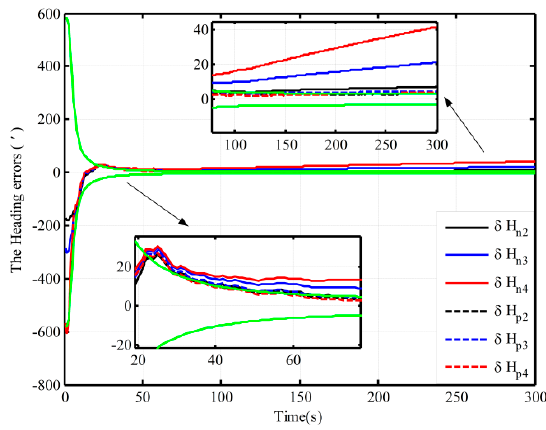
Figure 4. The open-loop alignment simulation results in the other three cases.